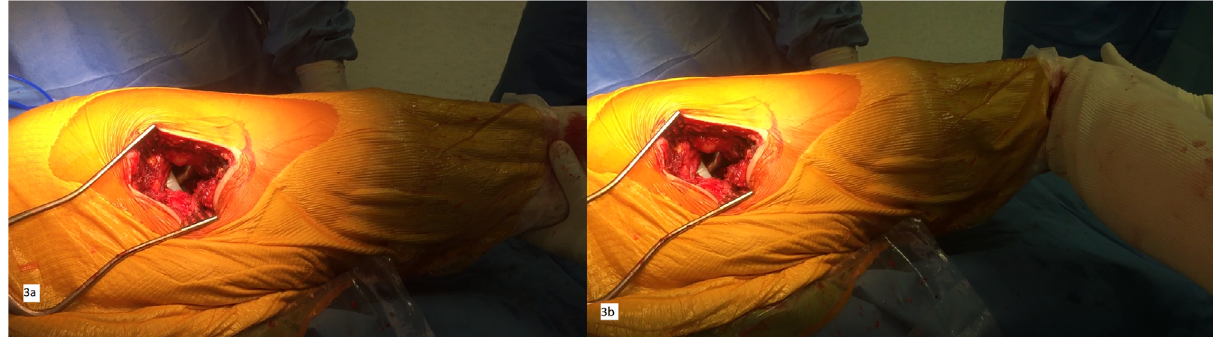
Figure 3. Intra-operative DMC testing with the posterior approach. (a) Test with the knee fully extended showing the “ piston sign ” . (b) Test with the knee fl exed at 90 (cid:4) of fl exion showing the disappearance of the “ piston sign ” .